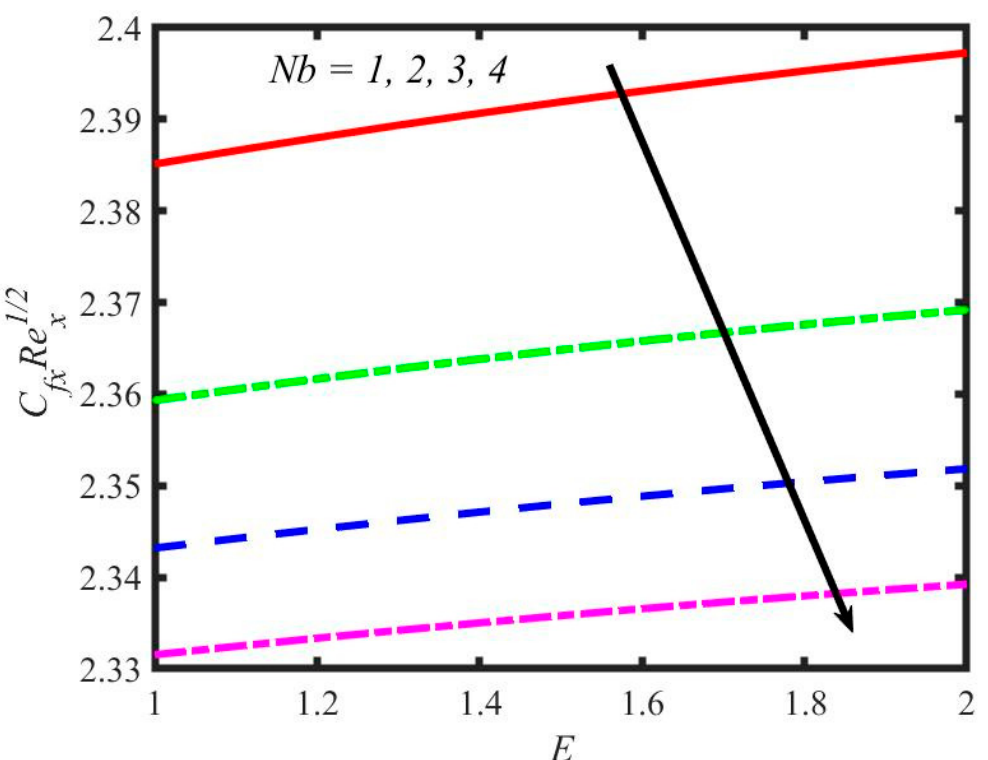
Figure 28. Variations in skin friction coefficient for Brownian motion parameter.